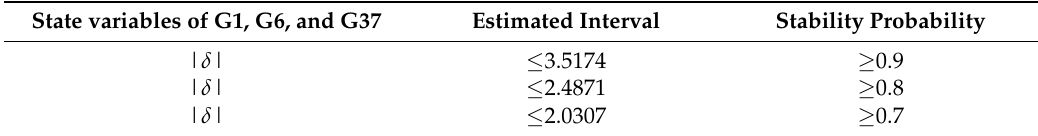
Table 2. Theoretical Results with the 145-Bus Test System.